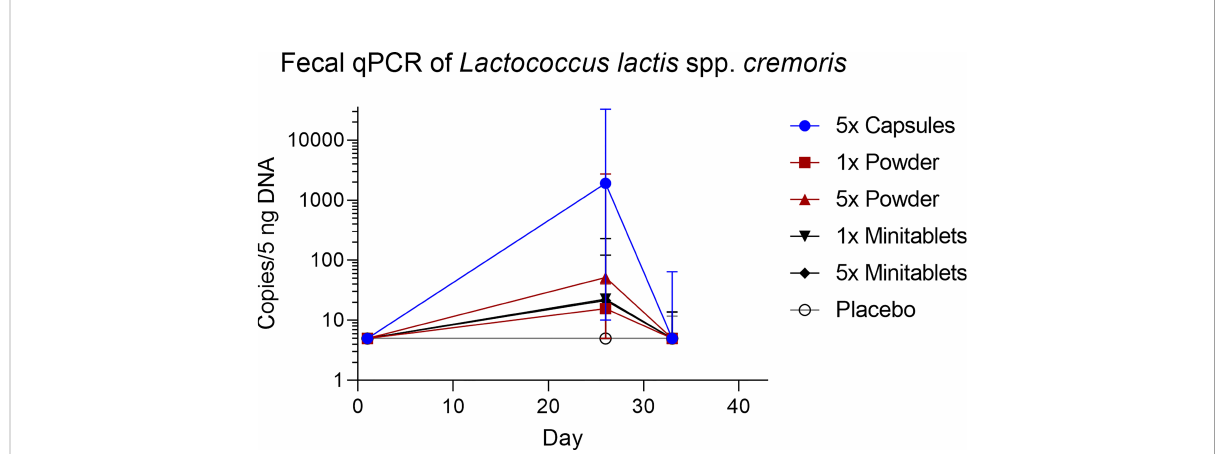
FIGURE 5 Fecal concentration of Lactococcus lactis spp. cremoris measured by quantitative polymerase chain reaction. Data are shown as median with range. qPCR, quantitative polymerase chain reaction.